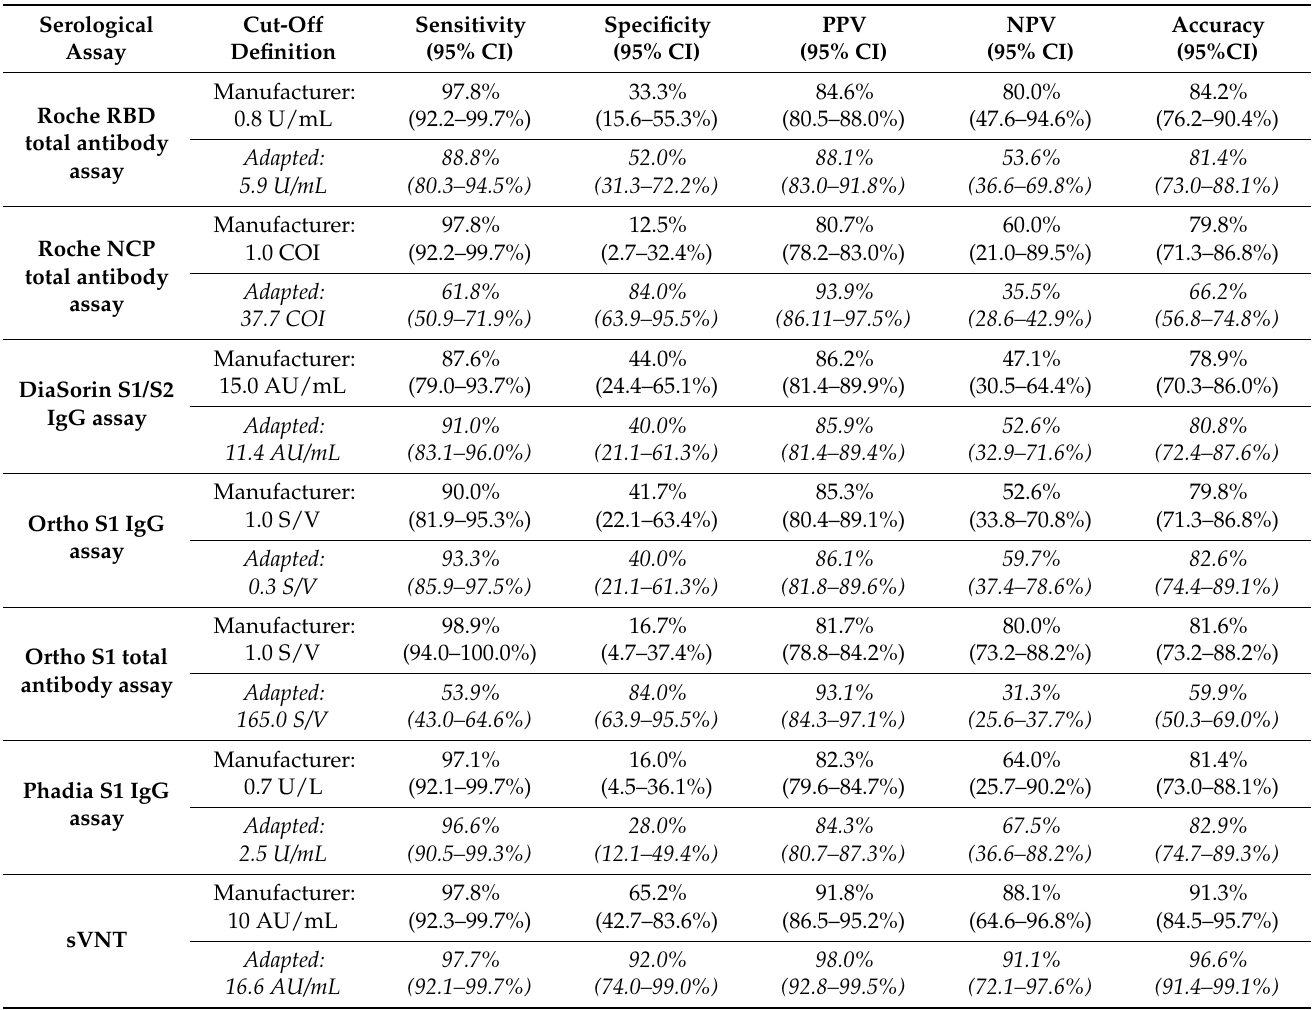
Table 1. Summary table of the analytical sensitivity, specificity, positive predictive value, negative predictive value, and accuracy of the six serological assays investigated in this study and sVNT technique in comparison with the pVNT. Results obtained with the adapted cut-offs are presented in